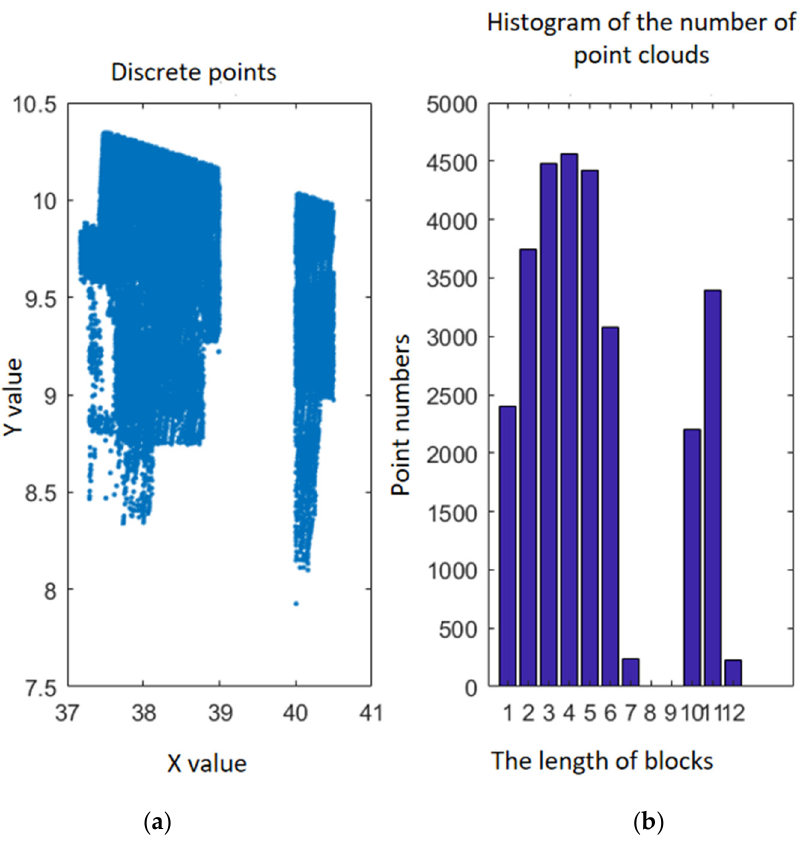
Figure 5. Neighboring splitting analysis of discrete points on a 2D plane. Note: display of 2D discrete points ( a ); the statistics of the number of point clouds in blocks ( b ).